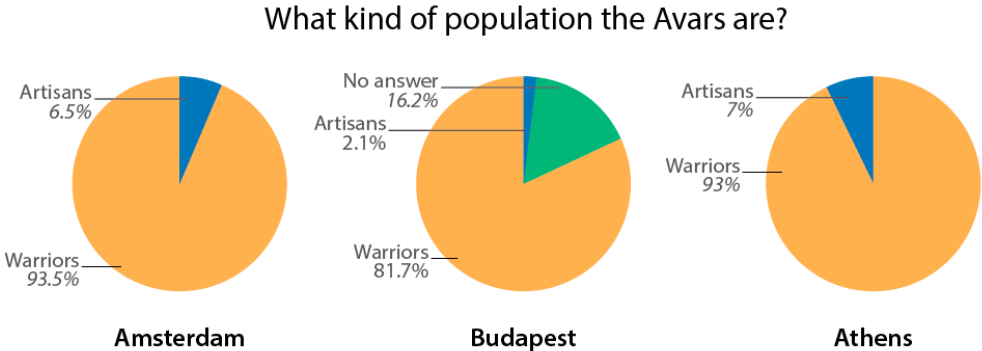
Figure 20. Image representing the visitor’s answers to one question related to cultural contents, at APM, NHM, and BCM.